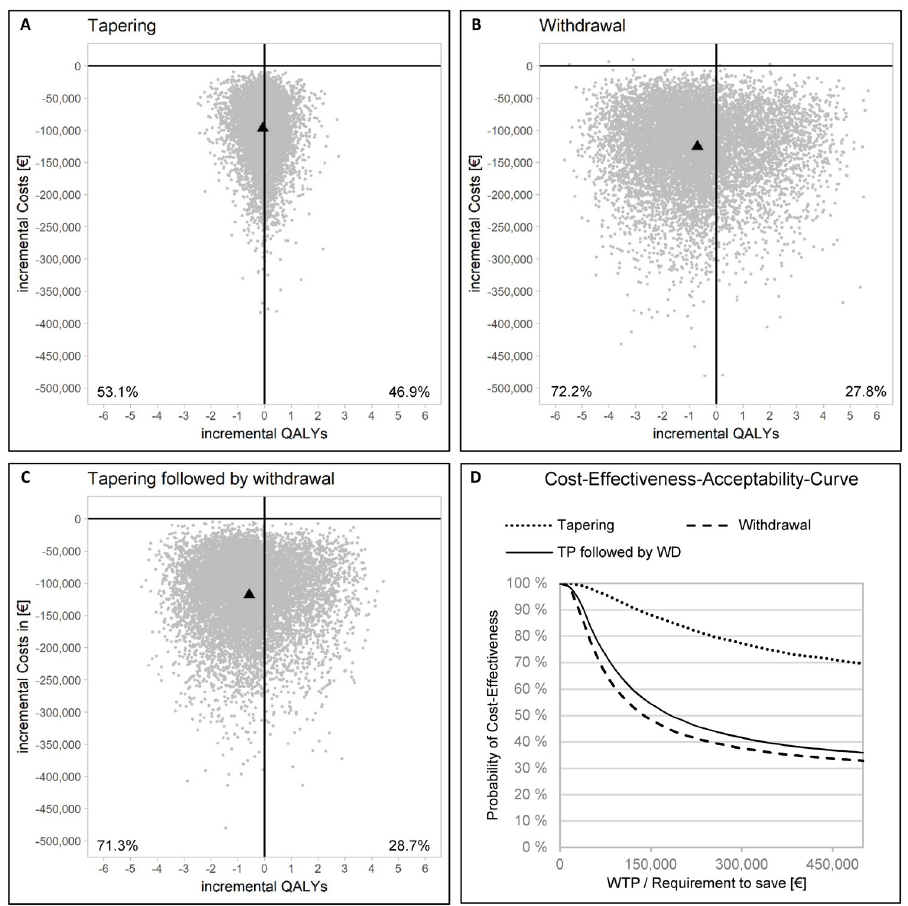
Fig 3. Results of Monte Carlo simulations depicted in incremental-cost-effectiveness-ratio (ICER) planes and cost-effectiveness-acceptability curves